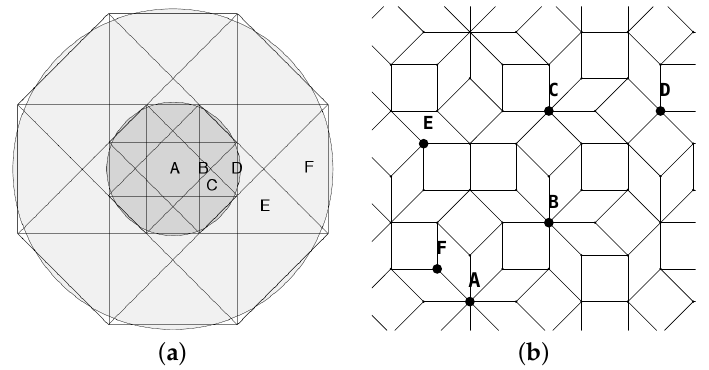
Figure 4. ( a ) the big octagon represents W, the selection window for the ABT in P (cid:48) . Circles represent the selection windows D (cid:48) for the OT for the values p = 0 and p = 1; ( b ) a portion of the OT with